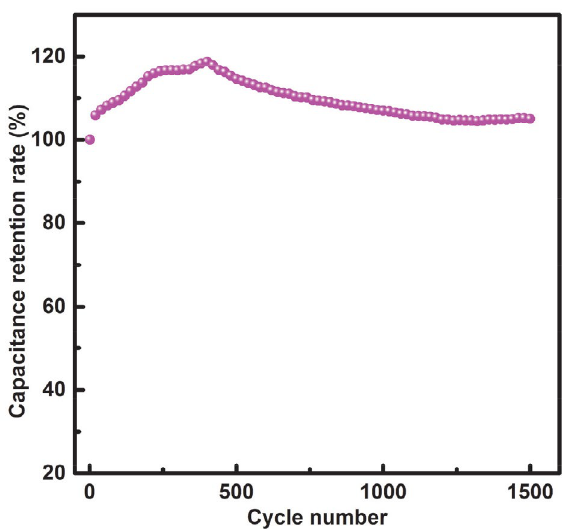
Fig. 11. Cycling stability of the 0.25 mmol Cu 2+ -doped MnO 2 elec- trodes at 5 A g –1